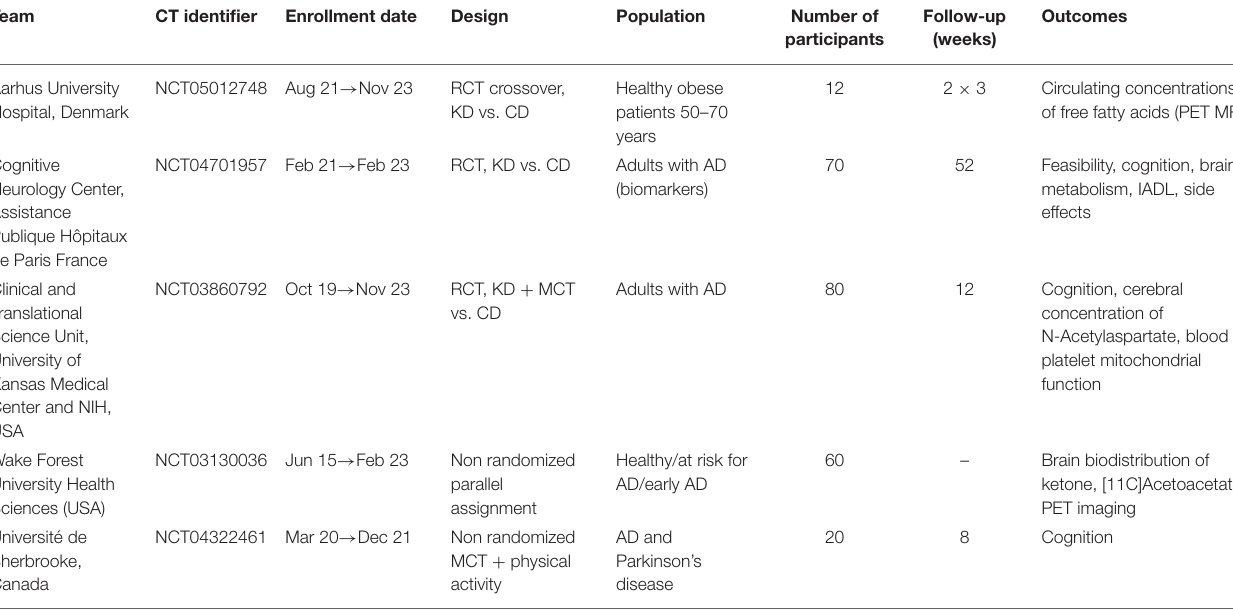
TABLE 2 | Ongoing trials examining ketone supplementation or ketogenic diet with cognitive outcomes (source: https://clinicaltrials.gov).